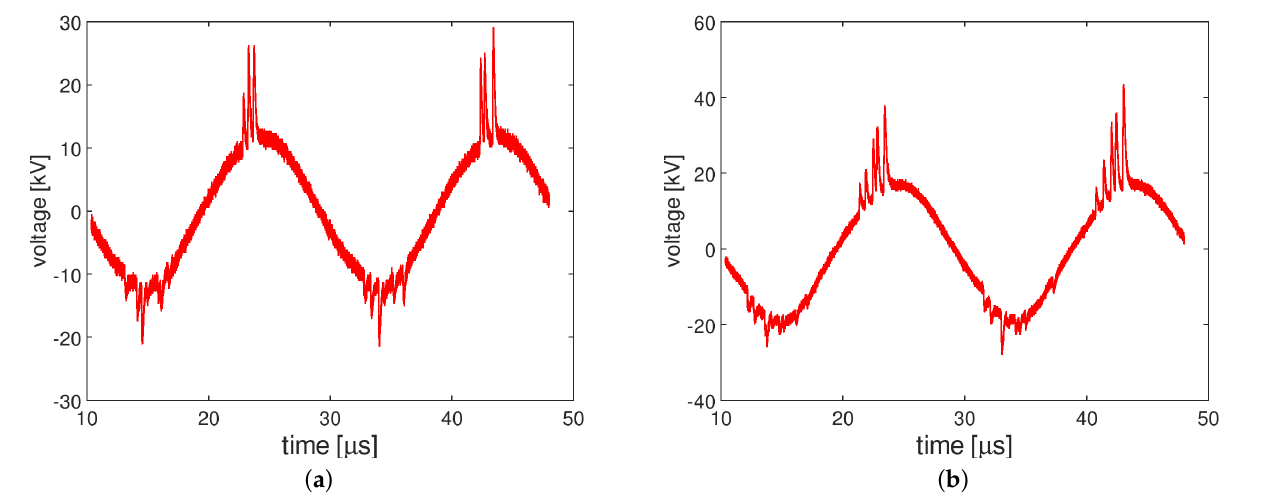
Figure 4. CeraPlas™F output voltage determined by capacitive probe for ( a ) 4 W ( b ) 8